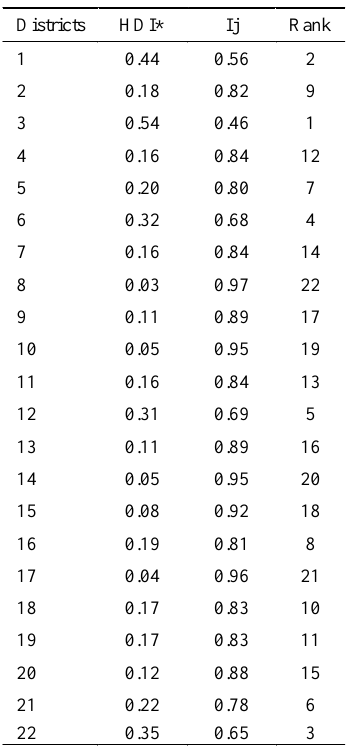
Table 2: HDI of 22 districts of